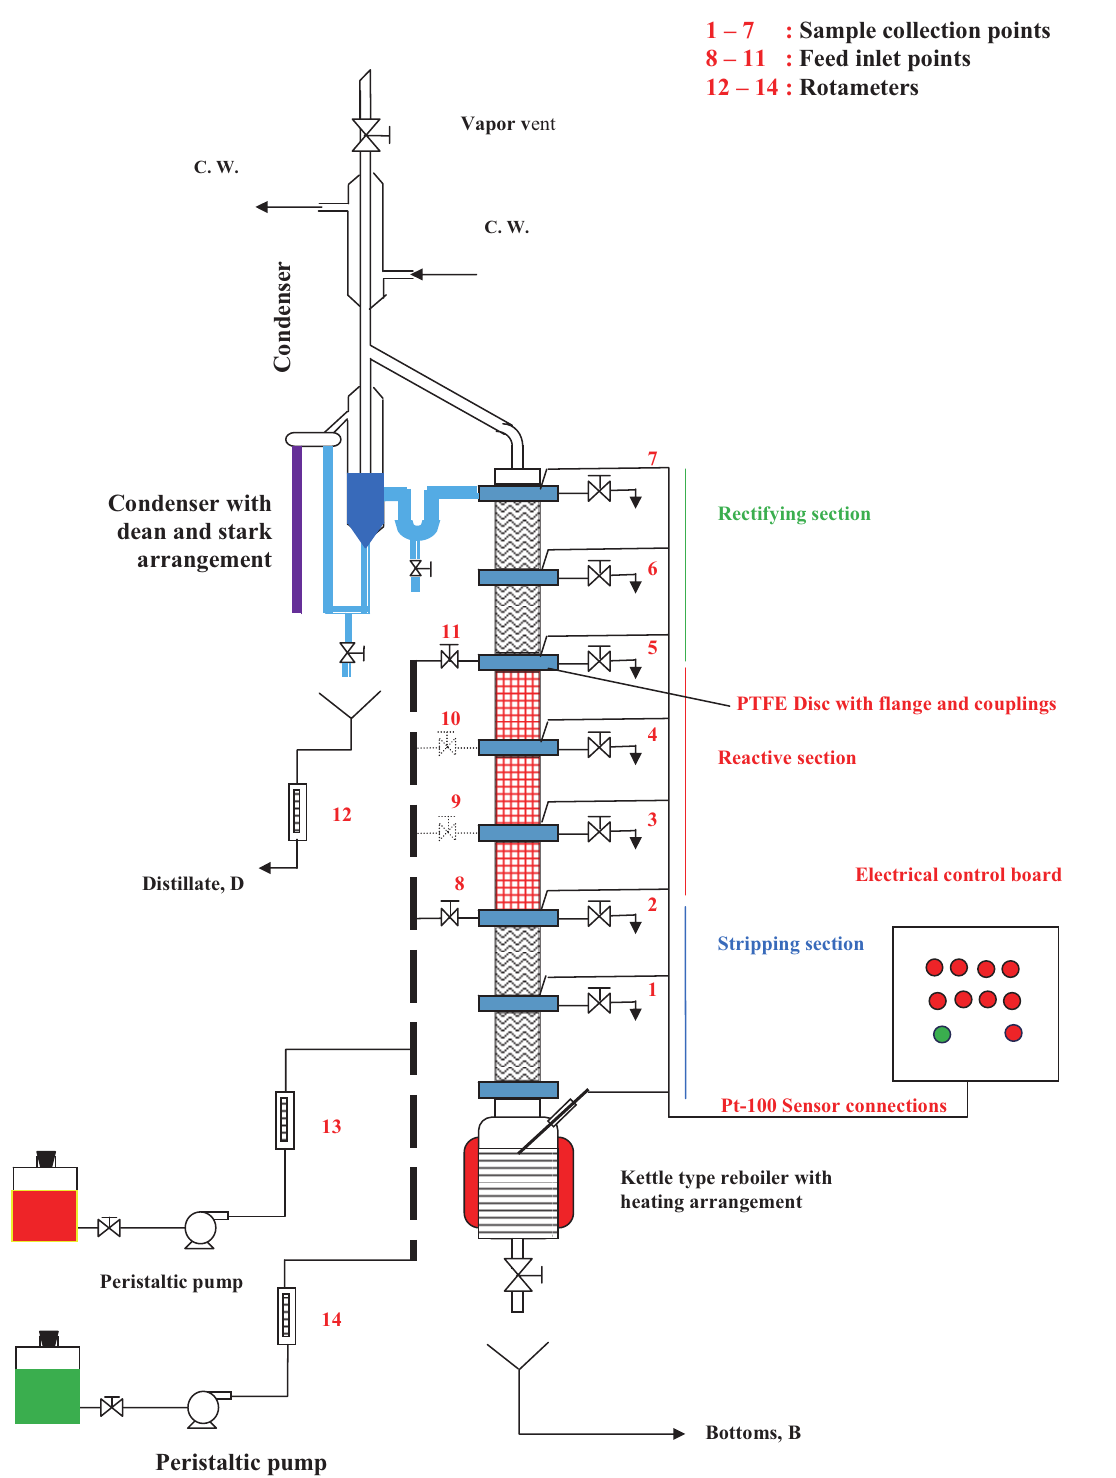
Fig. 1 Schematic of continuous reactive distillation column Fig. 1 – Schematic of continuous reactive distillation